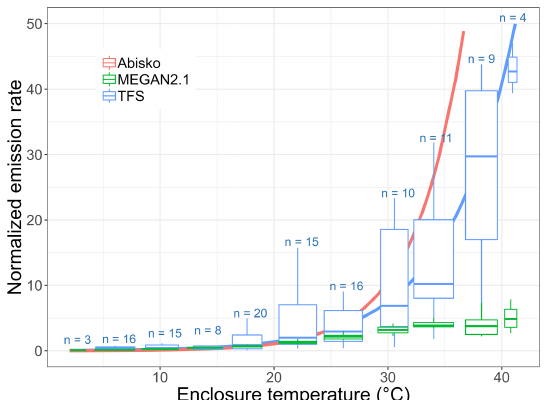
Figure 9. Normalized isoprene surface emission rate (emissions at 20 ◦ C set equal to 1.0) as a function of enclosure temperature (in degrees Celsius). This figure shows the response to temperature as observed at Toolik Field Station (TFS, in blue) and Abisko, Sweden (in pink; Tang et al., 2016), and as parameterized in MEGAN2.1 (in green). The blue solid line is the exponential fit at TFS. The term n denotes the number of measurements in each enclosure tempera- ture bin. It should be noted that the enclosure temperature was on average 5–6 ◦ C warmer than ambient air due to greenhouse